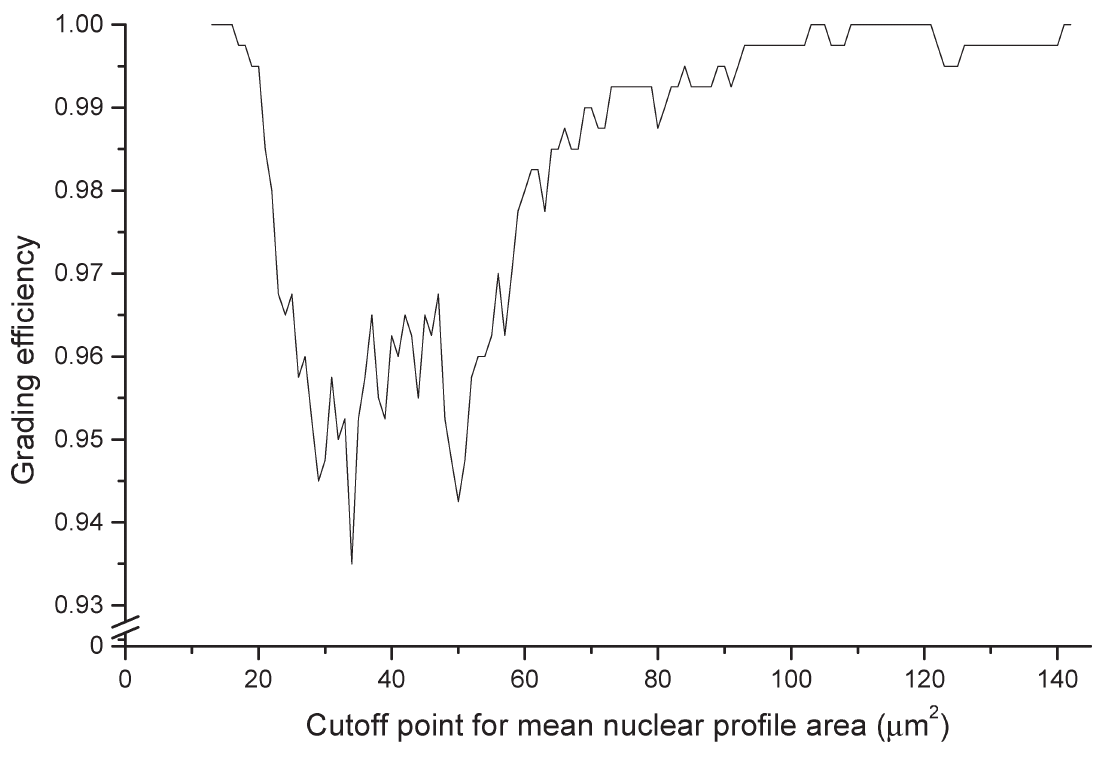
Fig. 3. The distribution of grading efficiencies (GE) for mean nuclear profile area at different cutpoints. The minimum GE is 0.93 at the cutoff of 34 µ m 2 .